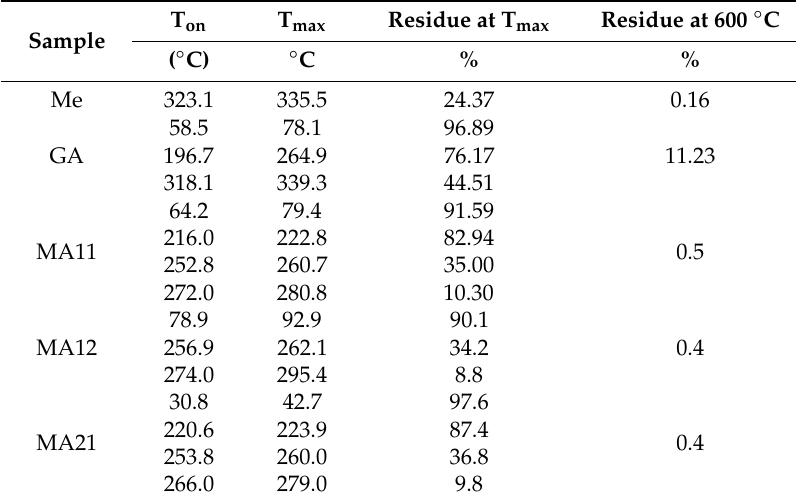
Table 2. TG / DTG data corresponding to Me, GA, and MA